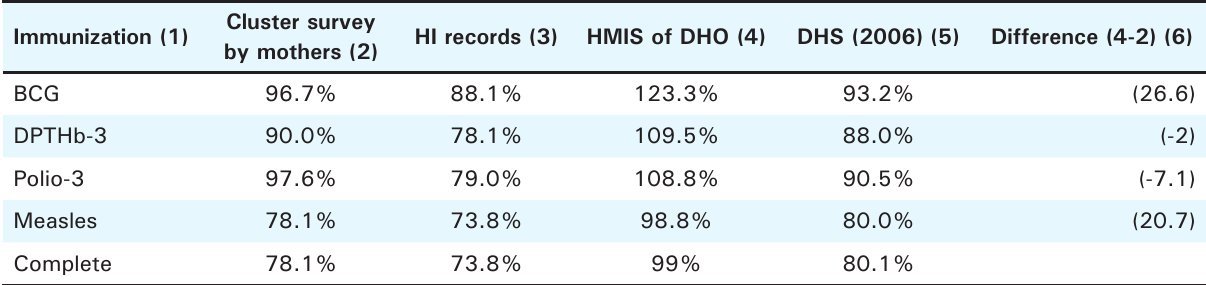
table 1. Immunization coverage (%) of children 12-23 months of